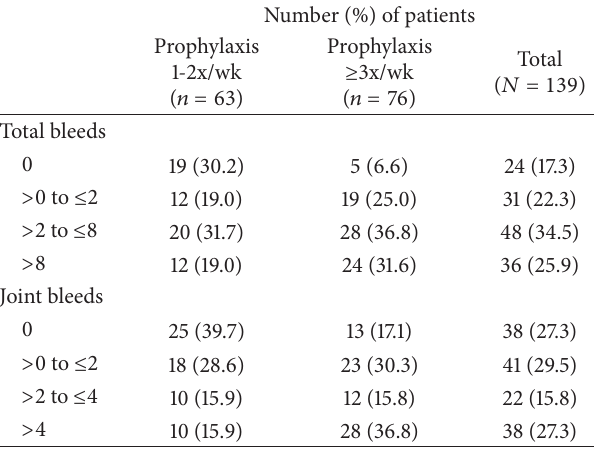
Table 4: Annualized bleeding